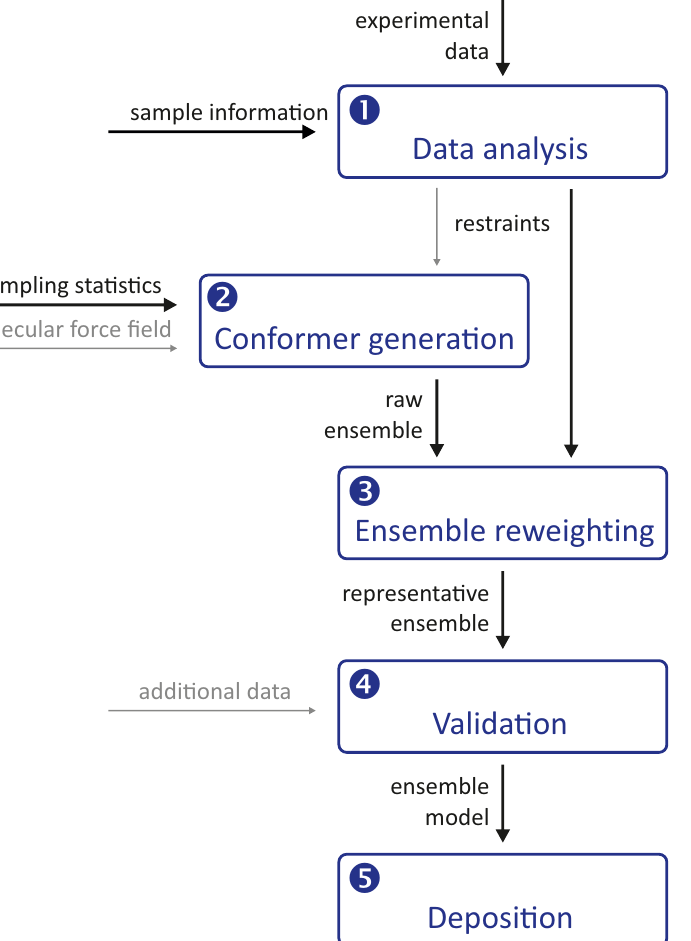
Figure 1. General pipeline for integrative and hybrid ensemble modelling. Thick black arrows denote required inputs, thin grey arrows denote optional inputs. The pipeline is preceded by the design and execution of experiments and is complemented by ensemble analysis. Numbers 1 to 5 denote the main modules that can be implemented using different